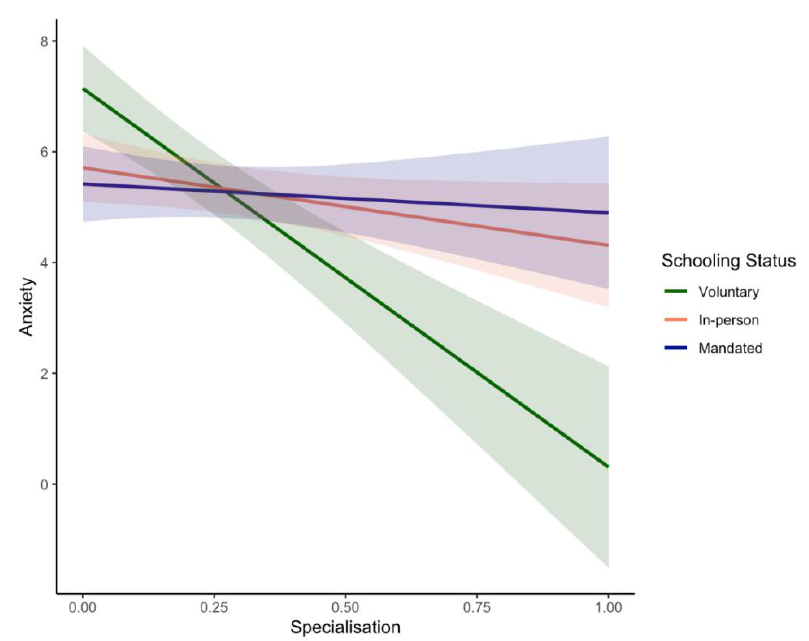
Figure 3. Simple slopes analyses demonstrating the interaction between specialisation and schooling status on parents’ anxiety.